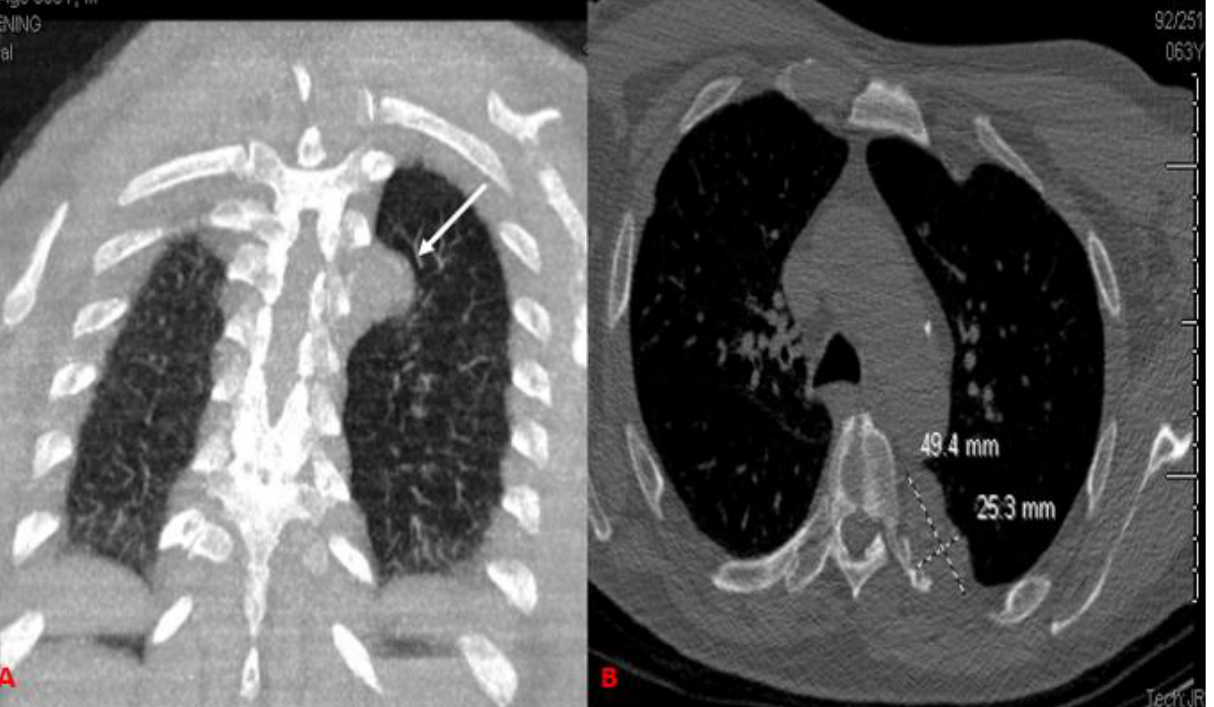
Figure 1. Non-contrast CT scan of the chest. Coronal ( A ) images show a well-circumscribed lobulated, homogeneous extrapleural mass (arrow) adjacent to the left 6th rib posteriorly. Bone window ( B ) shows subtle erosive changes at the left costovertebral junction adjacent to the mass. The homogeneous mass completely surround costovertebral junction.